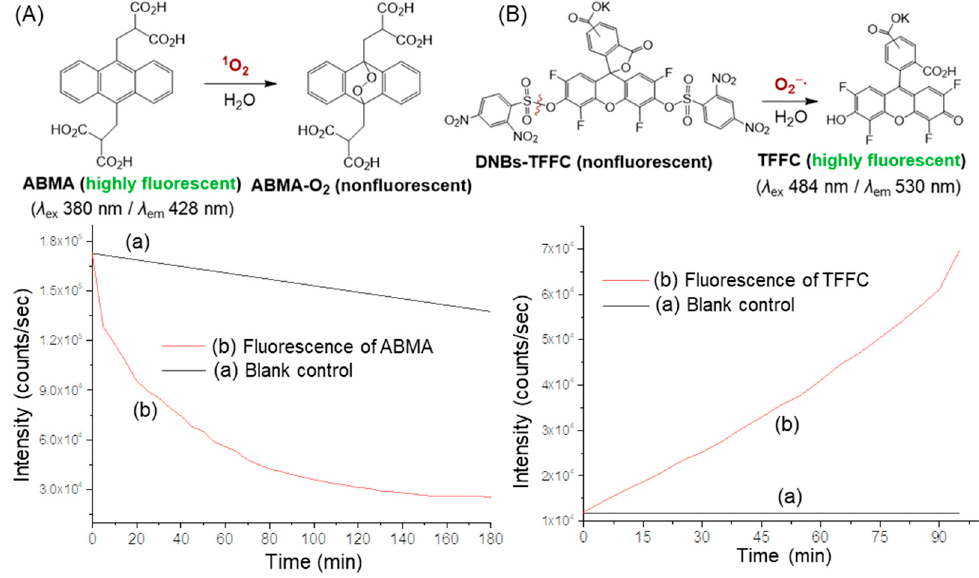
Figure 7. Fluorescence (FL) emission spectra of ( A ) ABMA and ( B ) tetrafluorofluorescein-10 ′ (or 11 ′ )- carboxylate (TFFC) to correlate directly the singlet oxygen ( 1 O 2 ) and superoxide radical (O 2 − · ) production efficiency, respectively, with (a) blank control and (b) a mixture of corresponding probe and cis - cup - 4 -C 2M ‒ 9 samples in DMF ‒ CHCl 3 (1:9, v / v ) at a concentration of 1.0 × 10 ‒ 5 M using ABMA as the 1 O 2 trapping agent at λ ex 350 nm and λ em 428 nm and DNBs-TFFC as the O 2 − · -acceptor agent at λ ex 484 nm and λ em 530 nm for detection with the irradiation of white light emitting diode (LED) light.